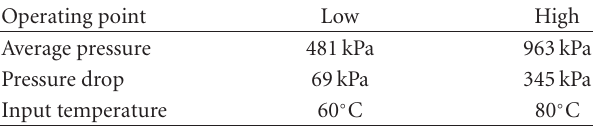
Table 2: Range of operating point parameters